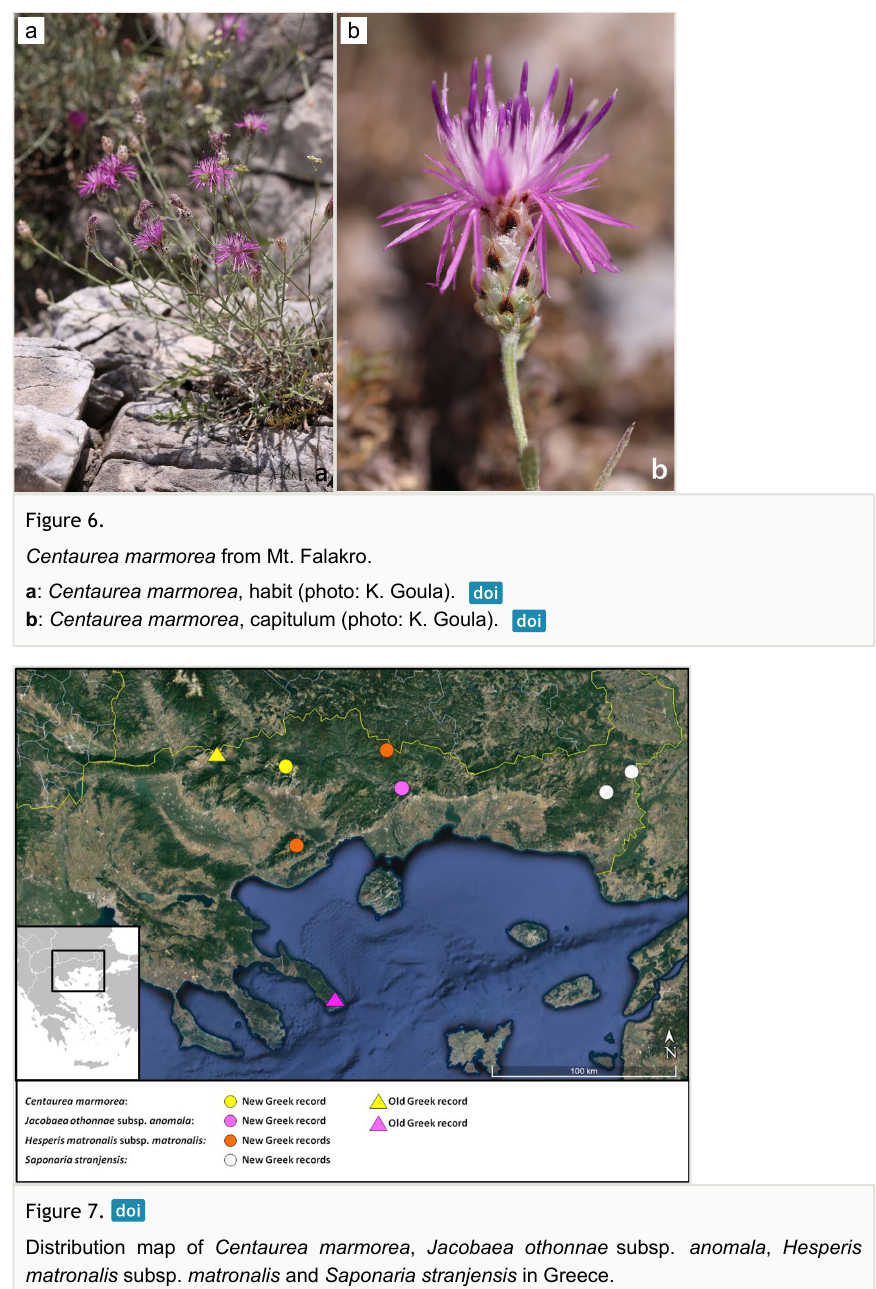
Figure 7. Distribution map of Centaurea marmorea , Jacobaea othonnae subsp. anomala , Hesperis matronalis subsp. matronalis and Saponaria stranjensis in